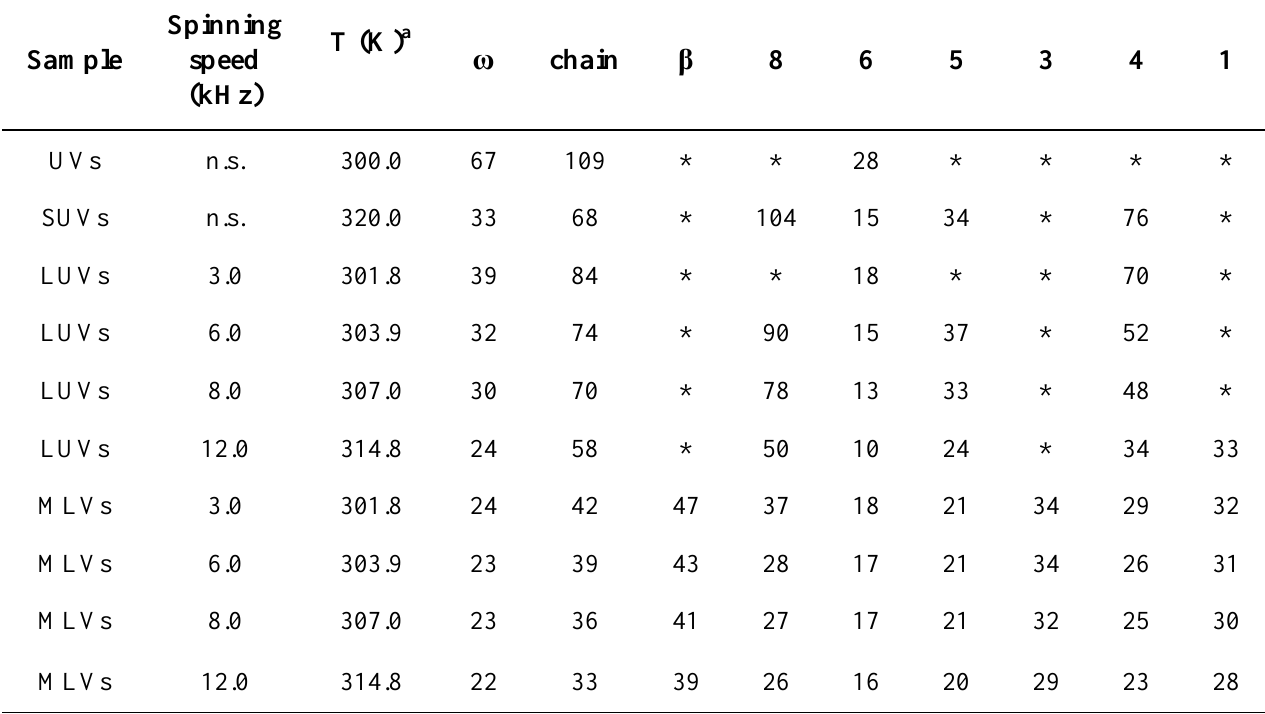
Table 1. Line width (in Hz) of some resonances, measured at half height in different samples of POPC liposomes. The error is ± 2